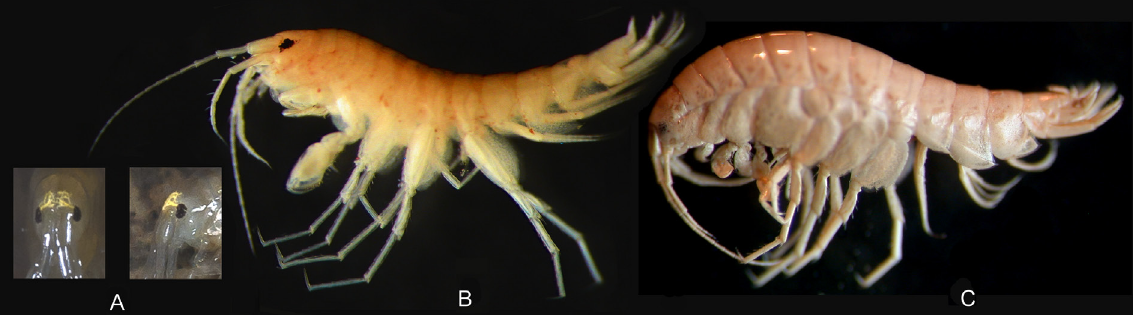
Fig. 2A-C. Synurella ambulans (F. Müller, 1846). A . Yellow spot on the dorsal surface of the head of live specimens (front and left side), MO. B . ♂, 4.2 mm, FENU X34906/Cr-1406, KF. C . ♀, 5.5 mm, FENU X34906/Cr-1406, BN, left side (preserved